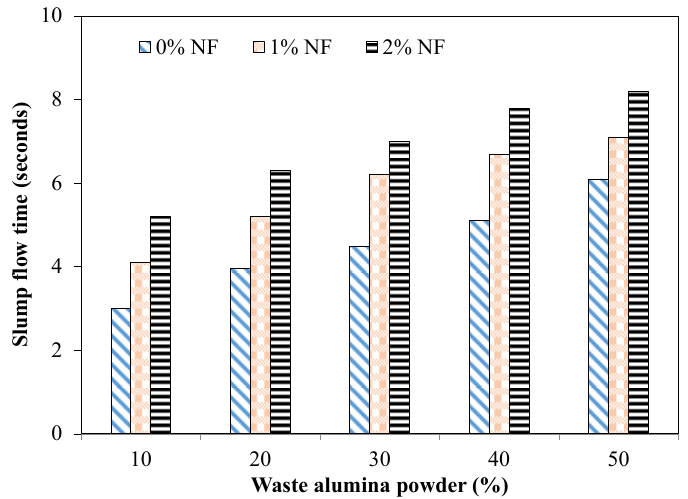
Figure 4. Slump flow time for mixture incorporating AP and NF.